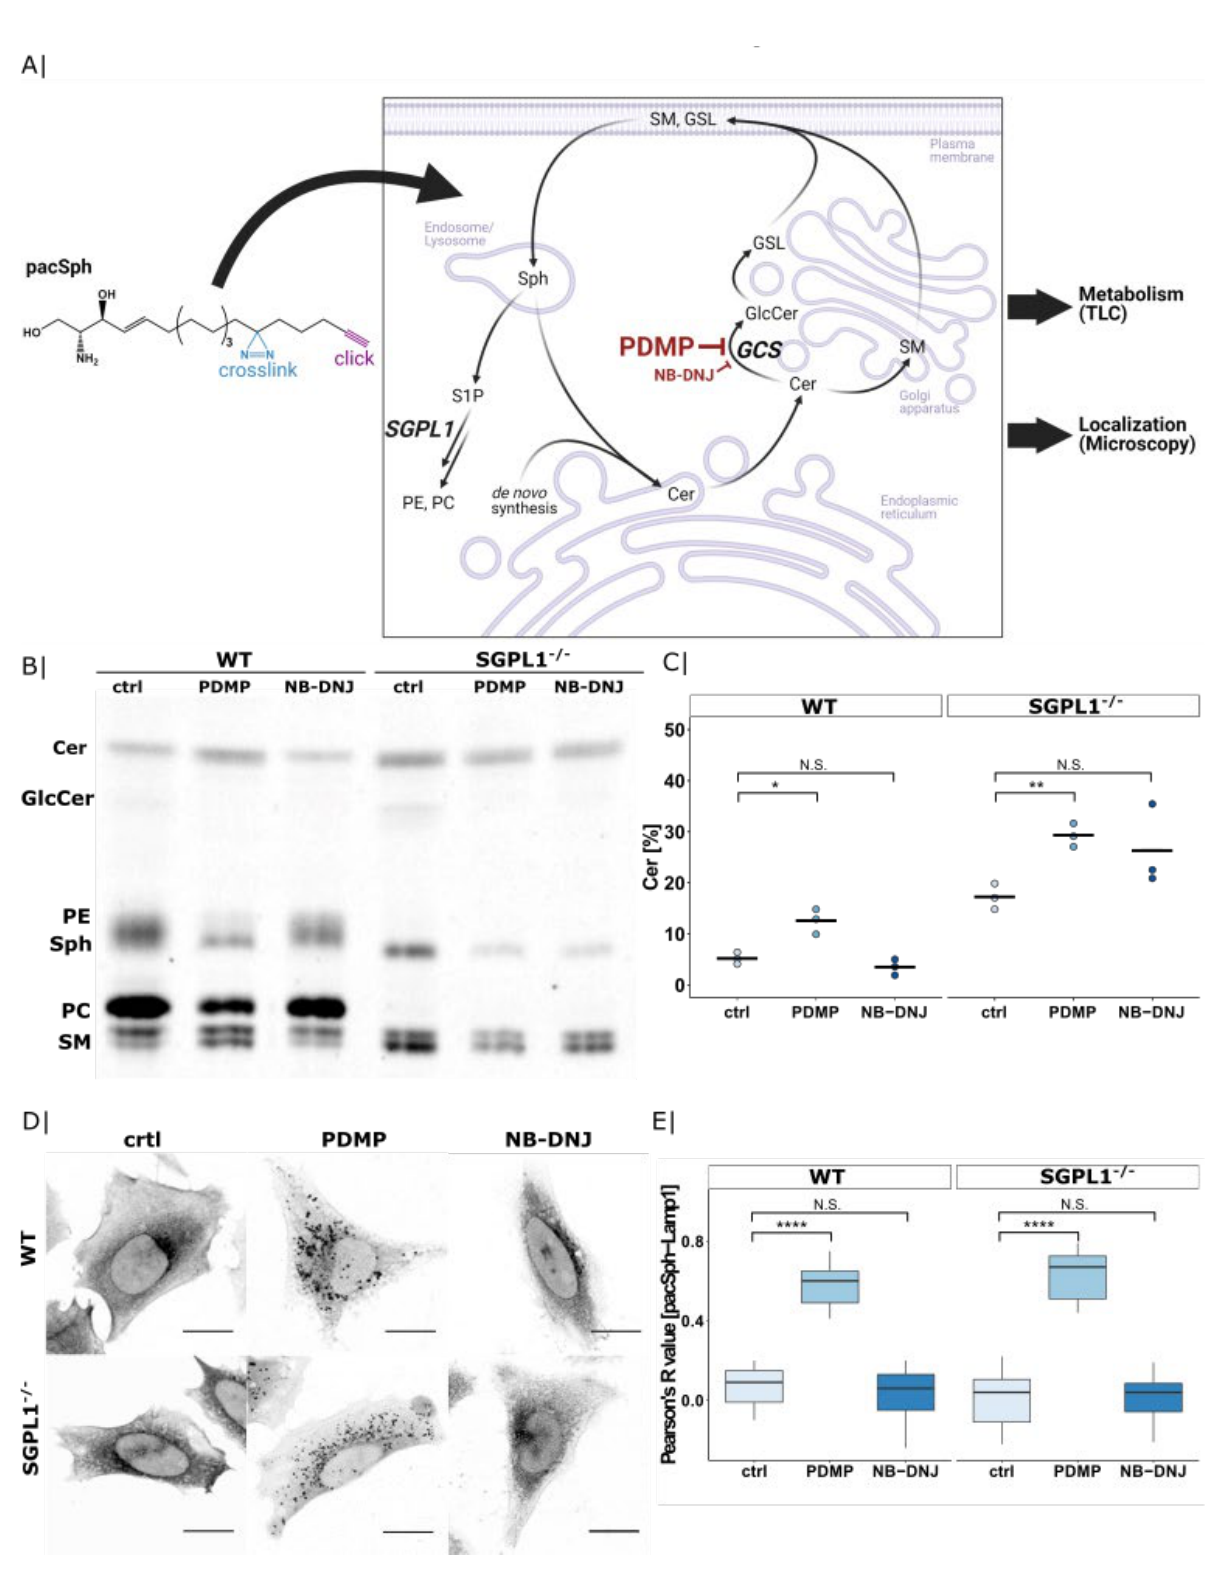
Figure 1. Ceramide accumulation inside lysosomes in HeLa WT and sphingosine-1-phosphate lyase knock-out (SGPL1 −/− ) cells upon 1-phenyl-2-decanoylamino-3-morpholino-1-propanol (PDMP) treatment. ( A ) Chemical structure of pacSph with highlighted functional groups and schematic illustration of its application in metabolism and subcellular localization studies. Created with BioRender.com. ( B ) Thin-layer chromatography (TLC) of pacSph metabolism in HeLa WT and SGPL1 −/− cells treated with PDMP (20 µM) or NB-DNJ (50 µM) for 22 h. Cells were labelled with pacSph (2 µM for 3 h) and lipids were extracted and clicked to a fluorogenic coumarin-azide. Sphingolipid species were separated by TLC. Cer— ceramide; GlcCer—glucosylceramide; PE—phosphatidylethanolamine; Sph—sphingosine; PC—phosphatidylcholine;